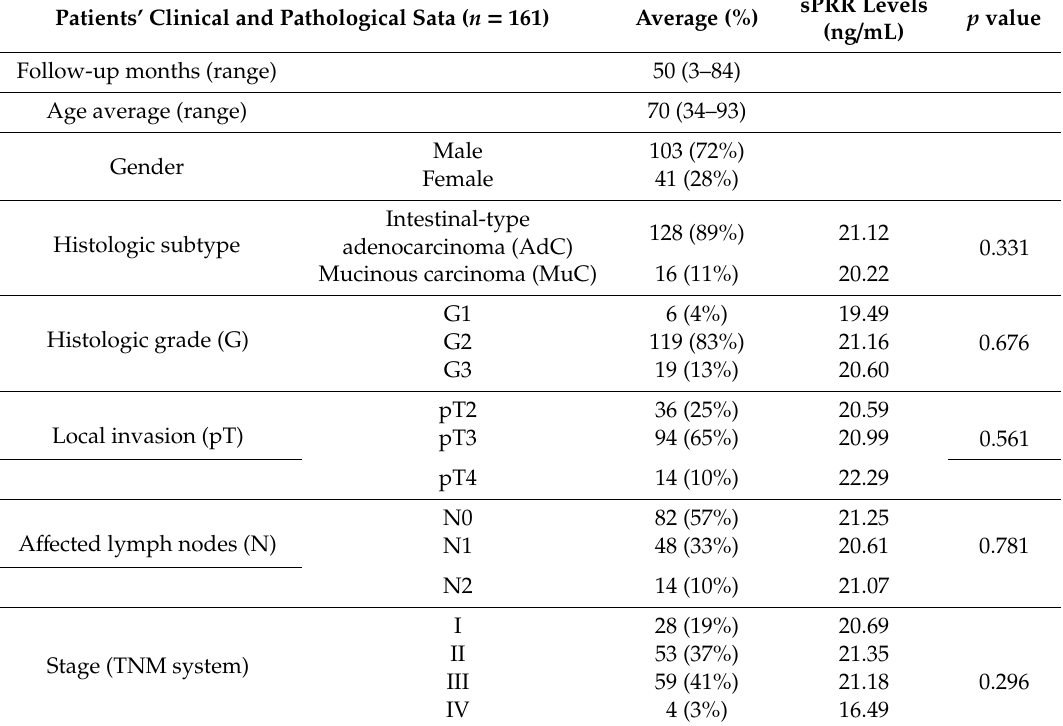
Table 7. Clinical and pathological parameters of the CRC patients used for soluble PRR analysis and the p values obtained from the correlation of soluble PRR plasma levels and CRC patients’ clinical data.